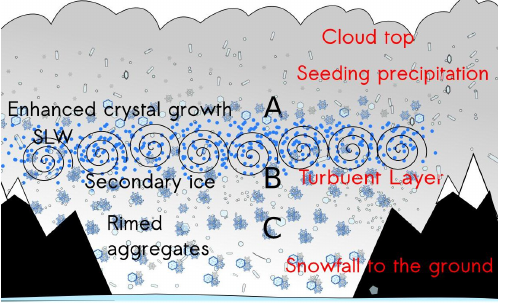
Figure 14. Schematic representation of the role of turbulence ob- served during EV3. The label “A” indicates area of enhanced Z DR , “B” indicates enhanced K dp , and “C” indicates enhanced Z H